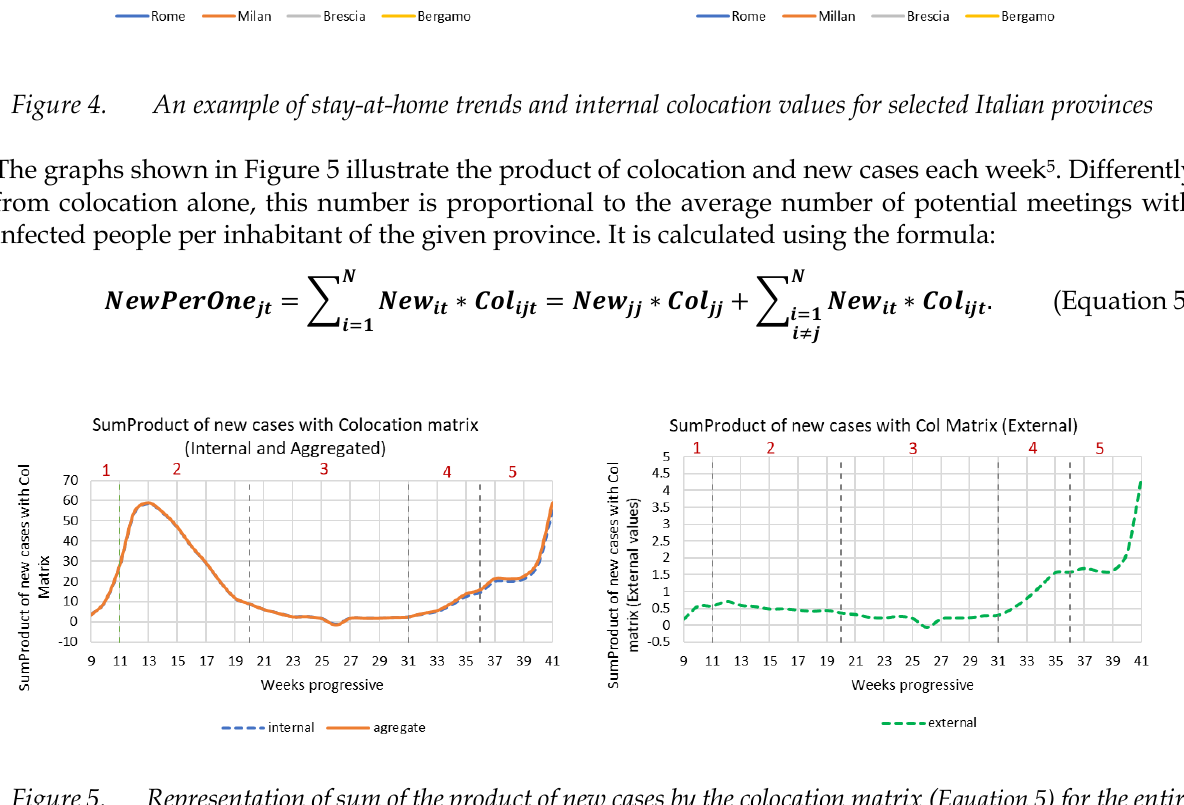
Figure 5. Representation of sum of the product of new cases by the colocation matrix ( Equation 5) for the entire country. The charts show the total number of potential meetings with contagious people. The blue dashed line corresponds to the first part in Equation 5 and is equal to the number of potential meetings with infected residents of their province. The green dashed line, represented at a smaller scale, shows the number of potential encounters with infected people from other